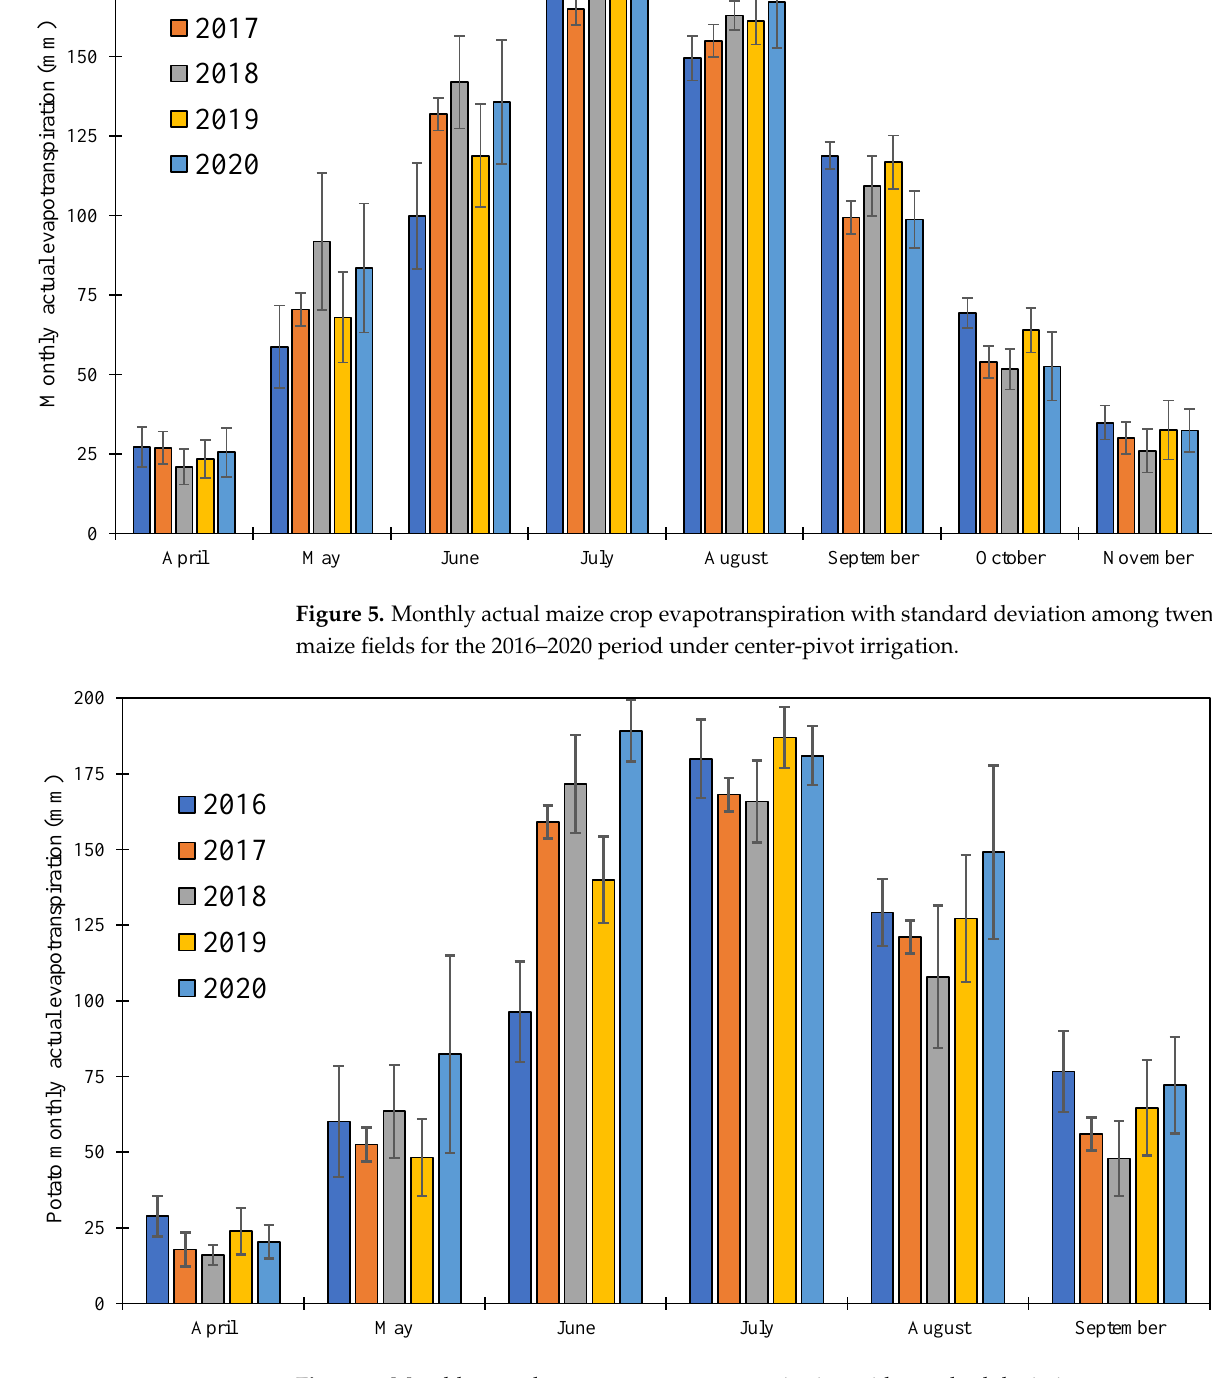
Agronomy 2022 , 12 , x FOR PEER REVIEW 10 of 17